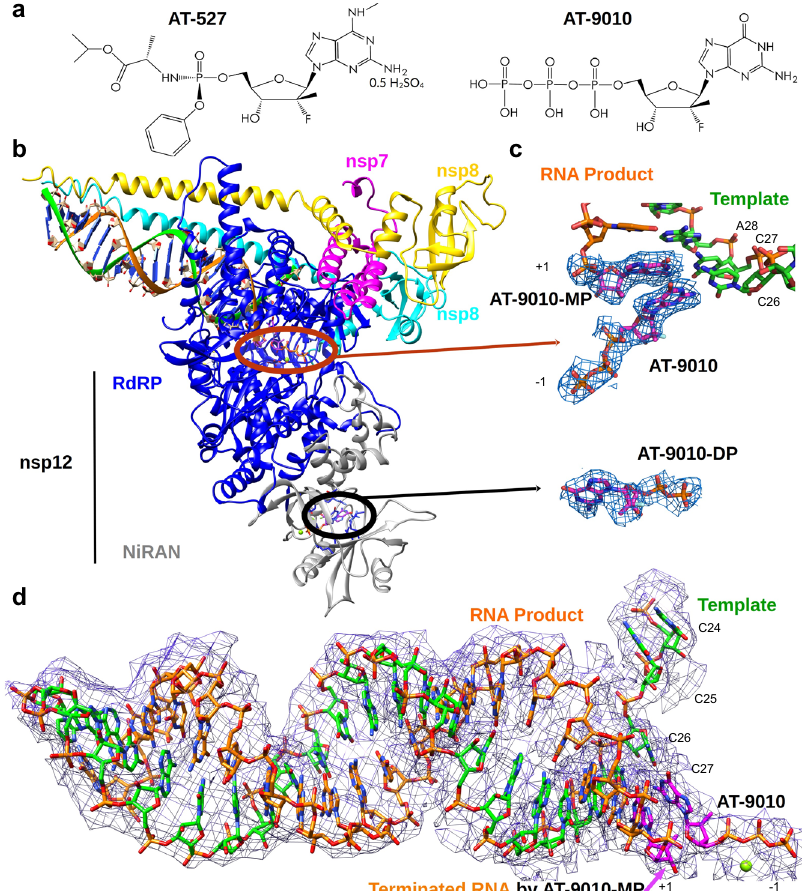
Fig. 1 Cryo-EM structure of the RTC with bound RNA and AT-9010 molecules and corresponding cryo-EM map. a Structure of the guanine analog phosphoramidate prodrug AT-527 (left) and its active triphosphate form AT-9010 (right) following activation by cellular kinases. b Ribbon and stick representation of the cryo-EM structure of nsp7-(nsp8) 2 -nsp12:AT-9010-terminated-RNA:(AT-9010) 2 complex. RNA, AT-9010 and protein shown with the following colors: template RNA, green; RNA product, orange; AT-9010, magenta; nsp7, pink; nsp8 1 and nsp8 2 , yellow and cyan respectively; and nsp12 in gray and blue for NiRAN and RdRp domains respectively. c Brown and black ovals are enlarged for RdRp domain and NiRAN domains, respectively, showing experimental cryo-EM map around AT-9010, In the RdRp, one AT-9010 monophosphate (AT-9010-MP) is incorporated at ( + 1) position, with an incoming AT-9010 occupying the ( − 1) position. In the NiRAN domain, AT-9010 is bound it its diphosphate form (AT-9010-DP). d Experimental cryo-EM map for RNA (stick representation), showing incorporated AT-9010-MP ( + 1) and incoming AT-9010 ( − 1). Bases of the template RNA involved in the interaction with AT-9010 are numbered as C24 – C27. All cryo-EM maps are represented at 3.5 σ representative of the general map of the entire complex at 2.98 Å